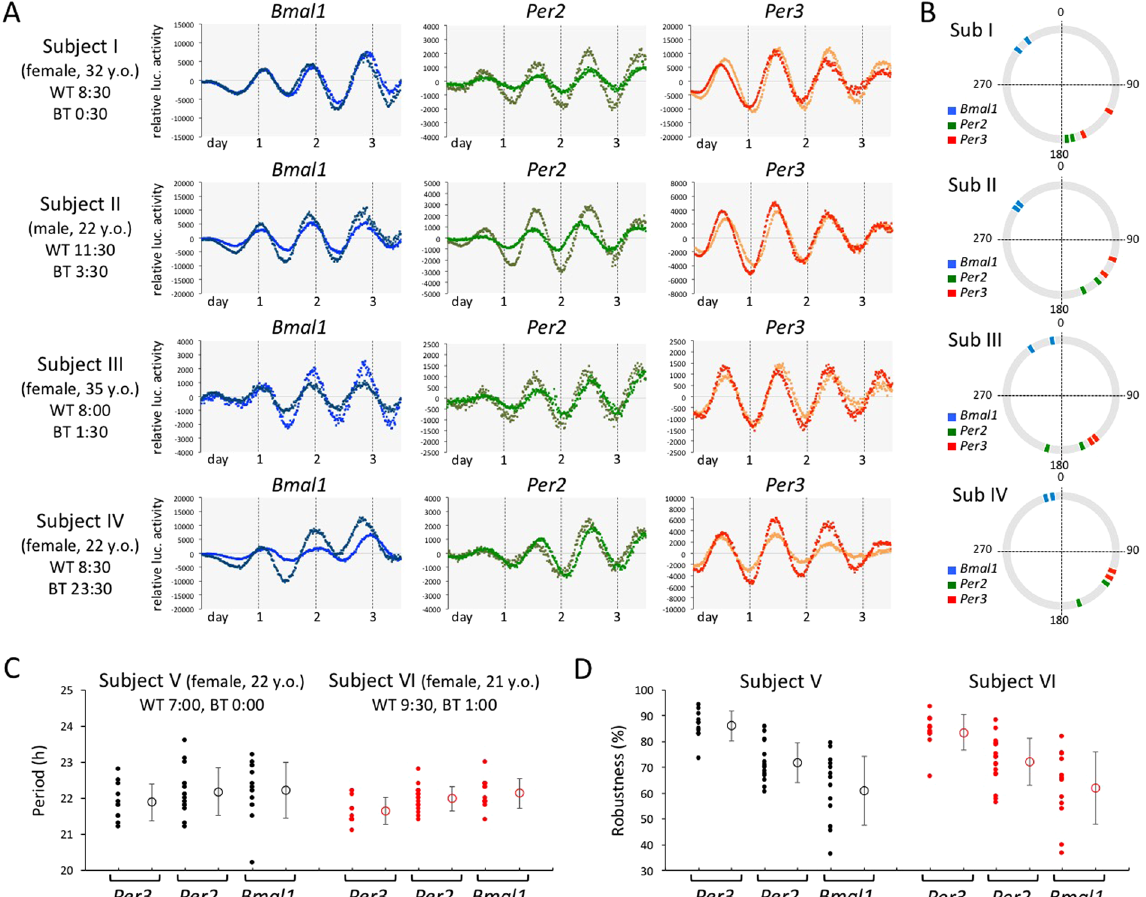
Figure 2. Phase relationship between bioluminescence rhythms of Bmal1-luc , Per2-luc and Per3-luc. ( A ) Hair roots obtained from four healthy subjects were infected with three adenovirus vectors carrying Bmal1-luc , Per2- luc , and Per3-luc . WT and BT indicate wake-up time and bedtime, respectively. Bioluminescence was measured in real time with a photomultiplier tube. To investigate reproducibility, two strands of hair were used for each virus vector (dark and light colored curves). Data sets were detrended by subtracting the 24-h running average from the raw data. ( B ) Phase angles of the data in ( A ) were calculated with a cosinor analysis and plotted on a circular graph. Oscillation data were considered reliable when both clear circadian oscillation persisted for ≥ 3 days and circadian robustness was 70% or more. ( C and D ) Period length ( C ) and robustness ( D ) were calculated with a cosinor analysis, and their average and standard deviation (SD) were compared among three adenovirus vectors in two subjects. Filled dots indicate the calculated period length and robustness for individual hair follicles, and open dots represent the mean ±